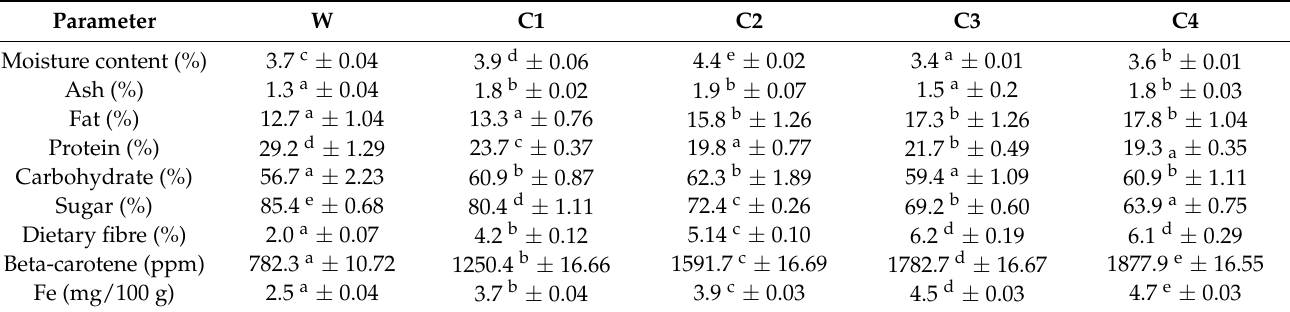
Table 1. Nutritional values of corn